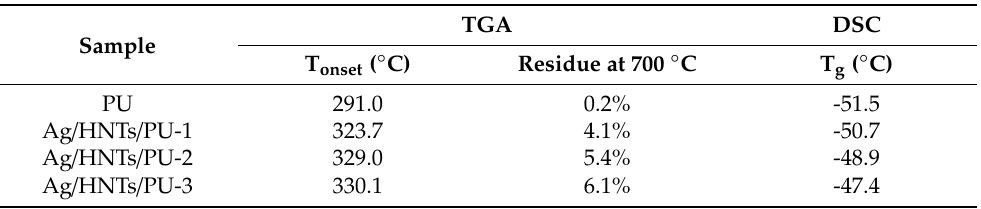
Table 3. Thermal properties of the Ag / HNTs /